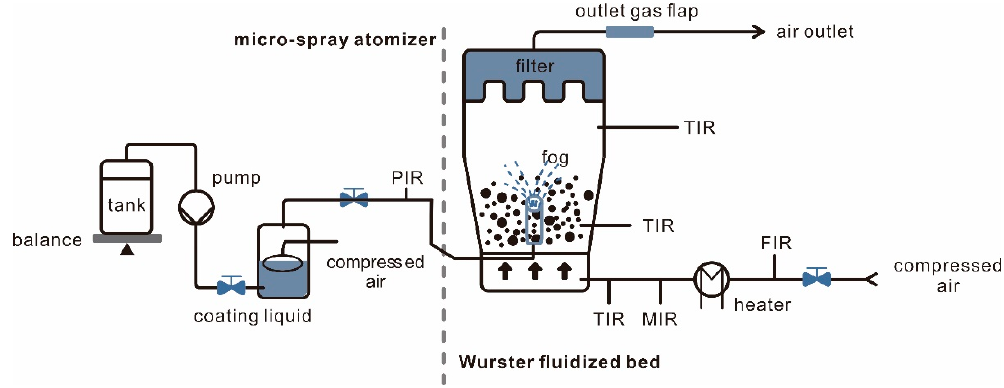
Figure 4. Scheme of the experimental setup using aerosols for particle coating in fluidized bed.